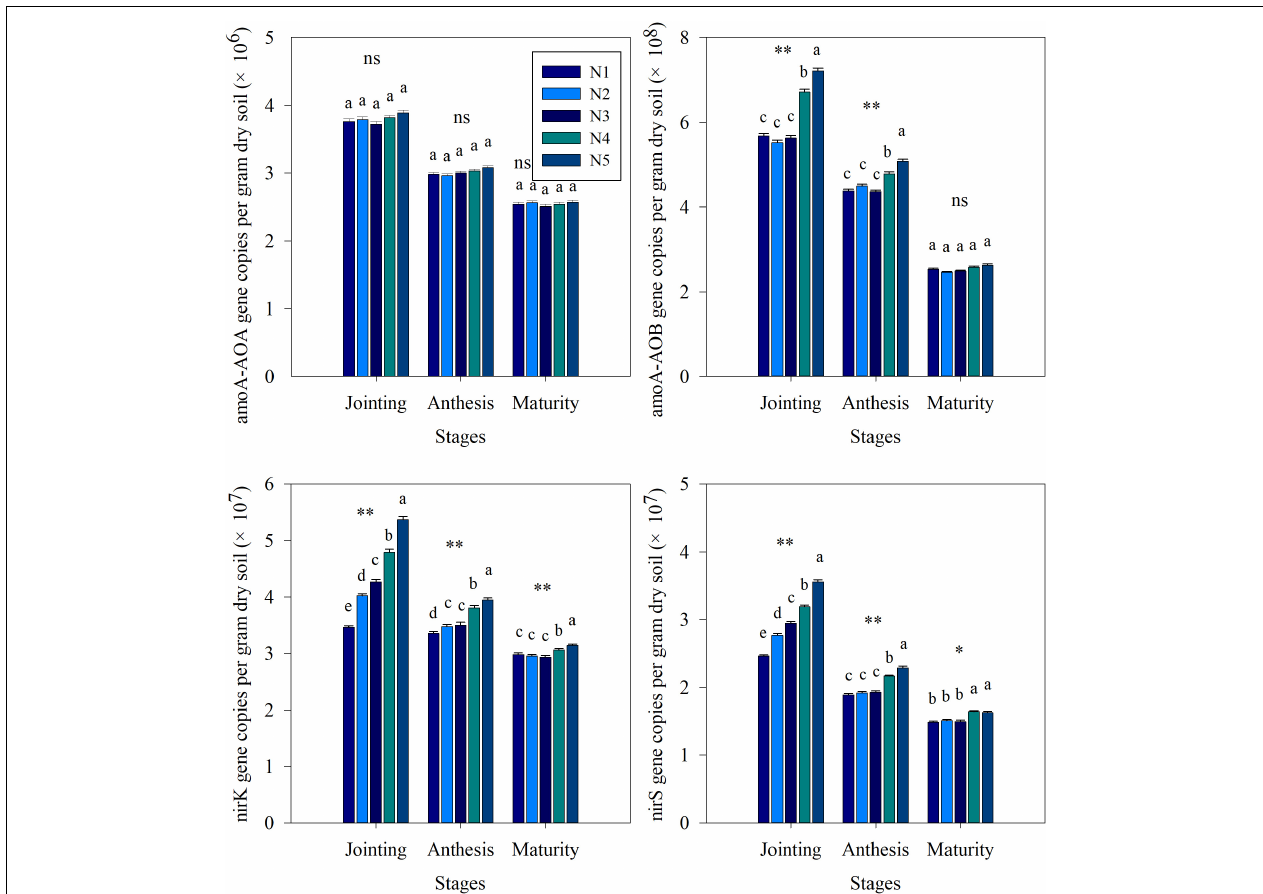
FIGURE 4 | The effects of split nitrogen fertilizer on the abundance of amoA- AOA, ammonia monooxygenase gene in AOA populations; amoA- AOB, ammonia monooxygenase gene in AOB populations; nirK , Cu nitrate reductase gene; nirS , cd1 nitrate reductase gene. Different letters indicate significant differences between treatments ( P < 0.05). ∗ , ∗∗ significant at the 0.05 and 0.01 probability levels, respectively, ns, no significant. N1 (basal/dressing, 100/0%), N2 (basal/dressing, 70/30%), N3 (basal/dressing, 50/50%), N4 (basal/dressing, 30/70%), and N5 (basal/dressing,